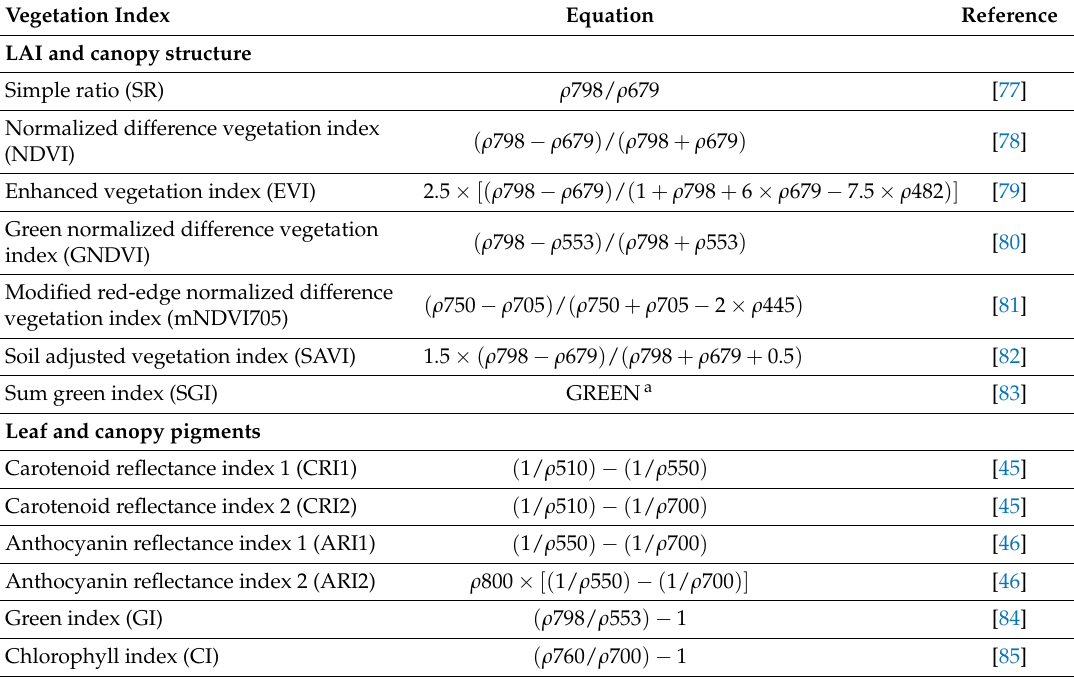
Table 3. Vegetation indices that were used in the study with their respective formulas and the references. ρ is reference at a specific wavelength in